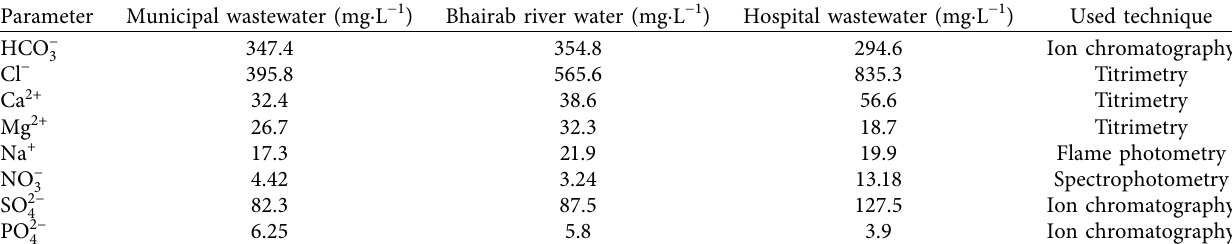
Table 1: The chemical composition of various biomass